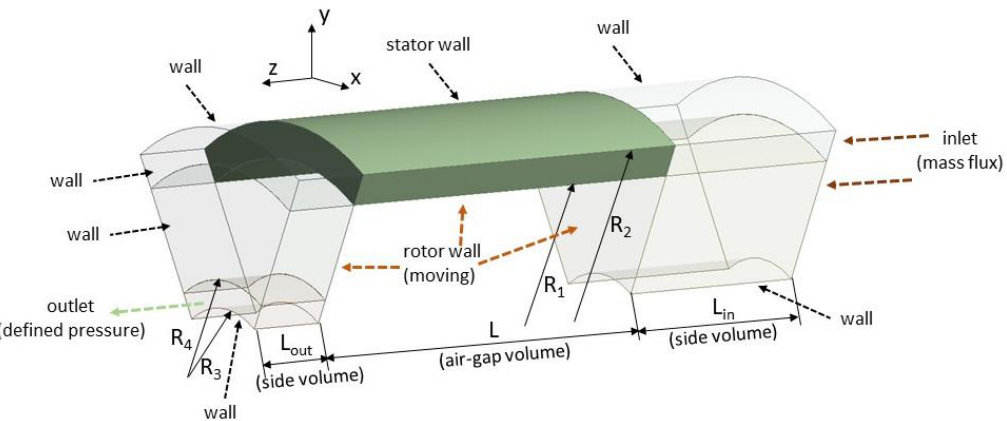
Figure 12. Air gap (solid) and outside volume (transparent) geometry as used in the initial model of a smooth air gap in Lee [6]. The applied boundary conditions are also depicted. Table 4. Dimensions and geometrical parameters of the smooth air gap from Lee [6].